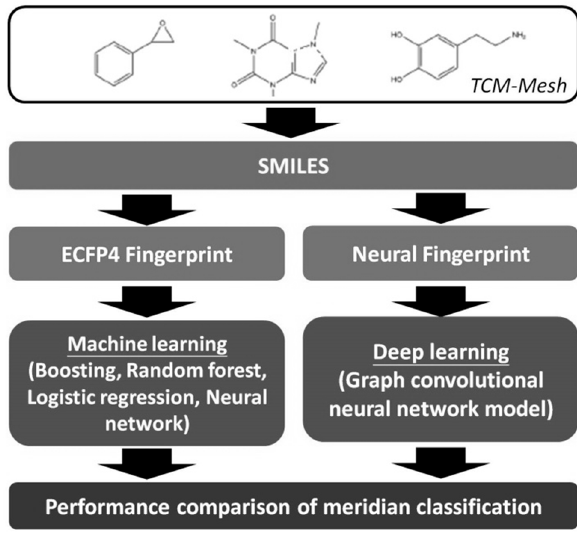
Figure 1. The entire workflow of our study.